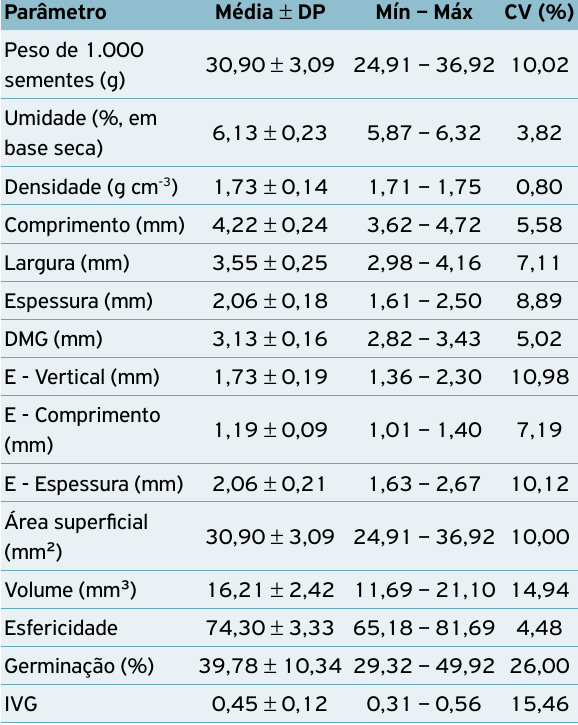
Tabela 1. Valores morfométricos, percentual de germinação e velocidade de germinação das sementes de Schinus terebinthifolius (n =